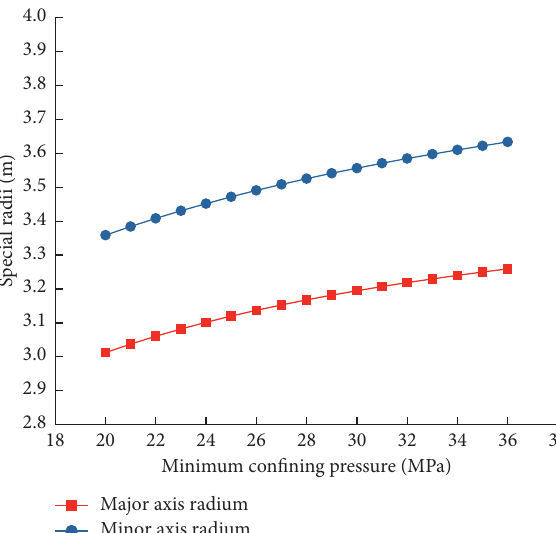
Figure 10: The relationship between special radii and stress